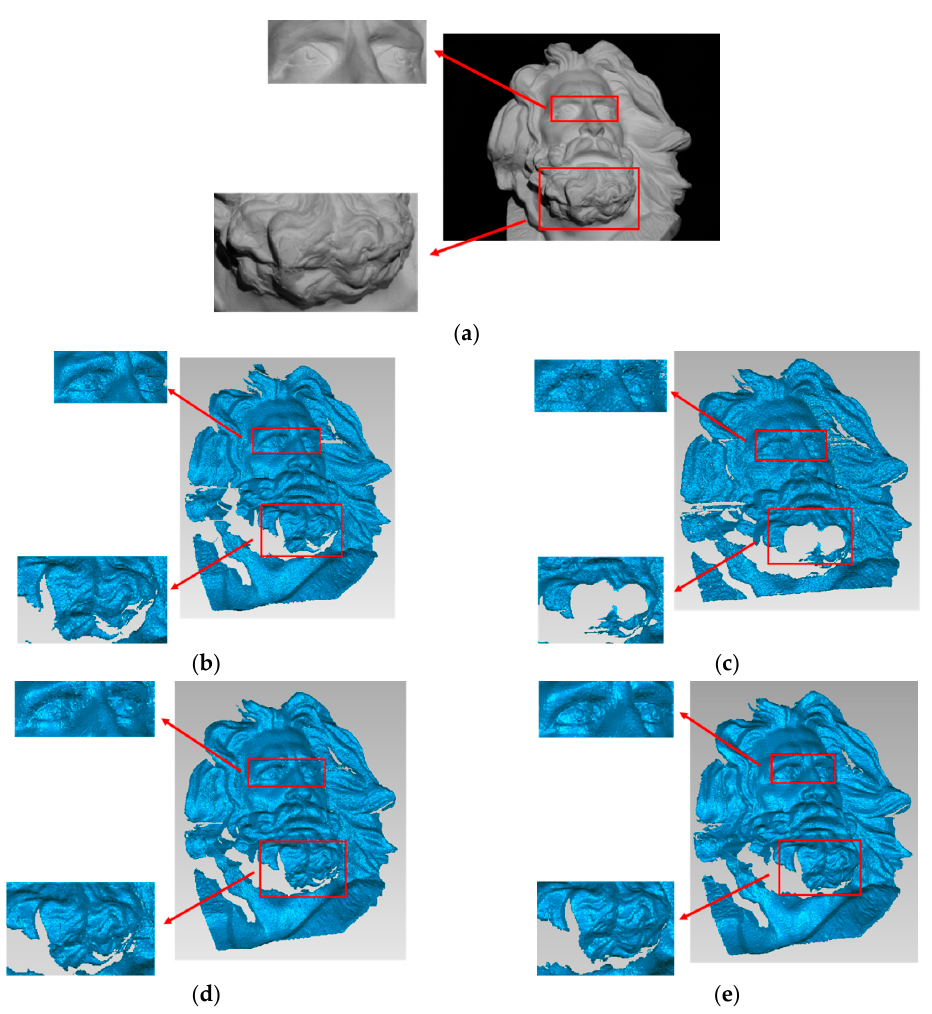
Figure 10. ( a ) Plaster statue of Marseille; reconstruction results of ( b ) Group A without GPR, ( c ) Group B without GPR, ( d ) the traditional method, and ( e ) the proposed